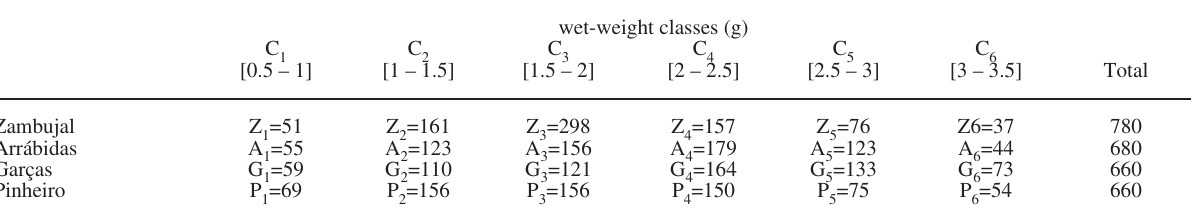
Table 1. – number of worms analyzed in sampling stations and in the 6 wet-weight classes